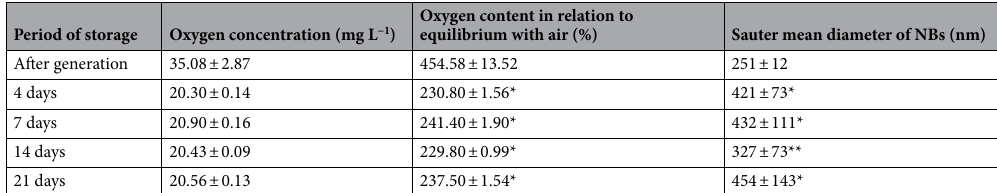
Table 3. Properties of ADONs during storage in closed glass containers (room temperature, atmospheric pressure), values are means ± SD, n = 3. Samples denoted with single asterisk are significantly different from sample taken directly after generation with α = 0.05 , while double asterisk denoted sample significantly different from sample taken directly after generation with α = 0.1